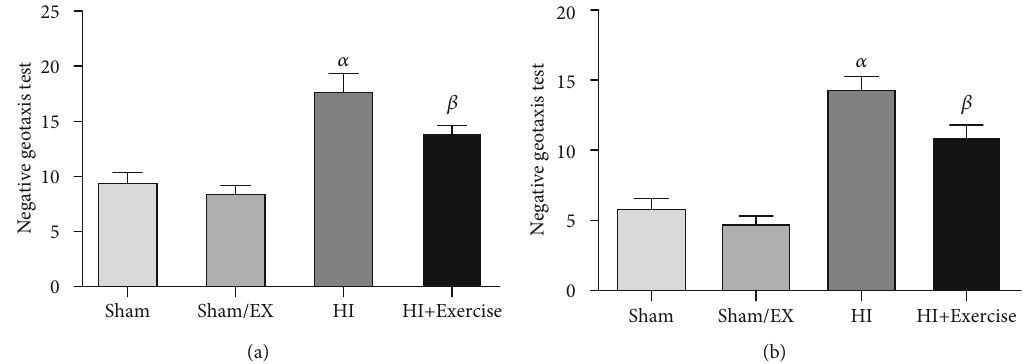
Figure 9: Negative geotaxis test of male (a) and female (b) in sham, HI, and HI/exercise groups. (a) α P < 0 : 001 , HI/exercise versus sham and sham/EX; ß P < 0 : 0001 , HI/exercise versus HI. (b) α P < 0 : 05 HI versus sham and sham/EX; ß P < 0 : 01 , HI/exercise versus HI ( mean ± S : E : M : , n = 20